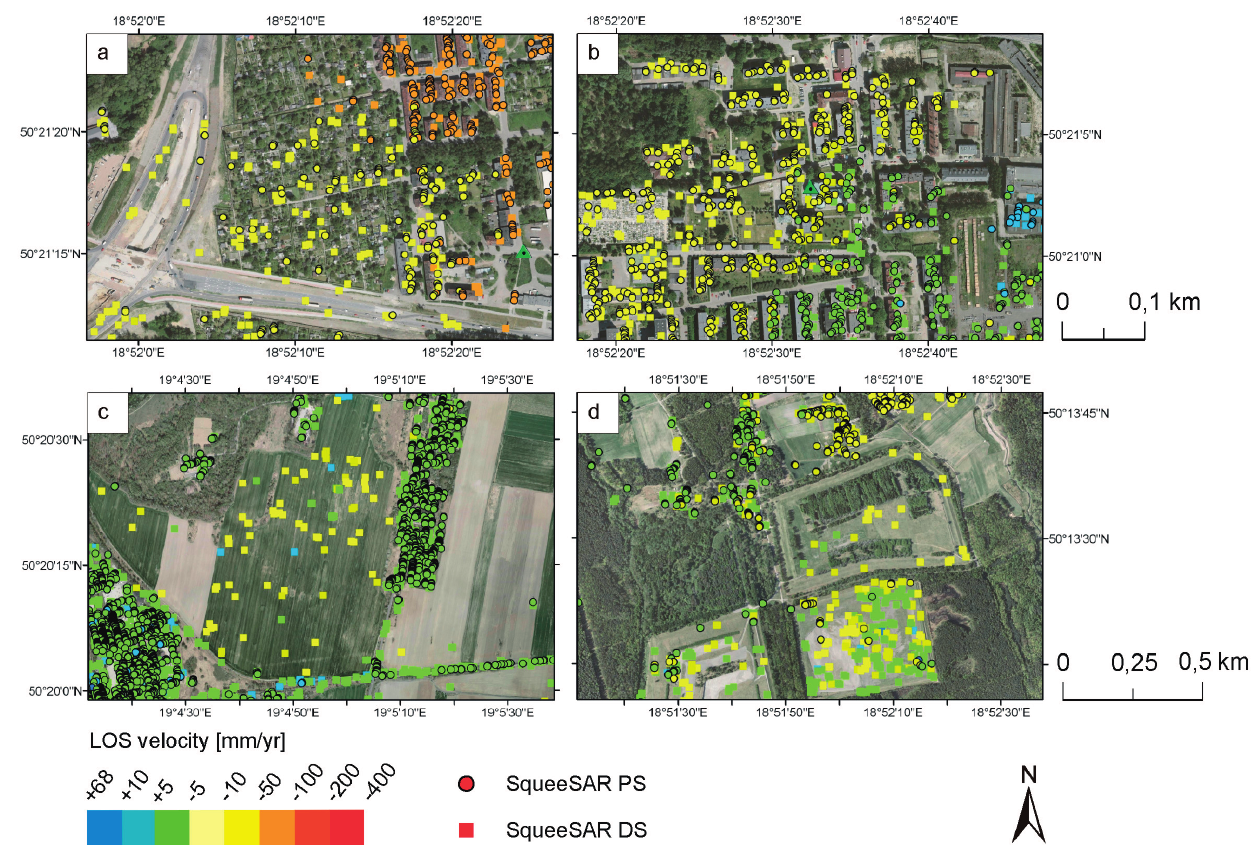
Figure 6. Point scatterers (circles) and distributed scatterers (squares) location over selected areas. Both measurement point (MP) types are presented in the same color scale by their Line of Sight velocity values. ( a ) Crossroad of national road no. 94 and Nowaka- Jeziora ń skiego street in Bytom; ( b ) Popie ł uszki street in Bytom; ( c ) Agricultural area in B ę dzin; ( d ) Agricultural area in Stara Ku ź nia. See location of these areas in Figure 4. The negative skewness in LOS velocity histogram is explained by the dominant subsidence detected in the USCB. The mean standard deviation, 2 mm/year, is consistent with the precision of the PSI techniques. Occasional and scattered higher values of standard deviation up to 11.93 mm per year are observed far away from the reference point (edges of the data frame) as well as in strongly subsiding areas (Figure 4c,d). As in all geodetic networks, the precision of the measurements tends to decrease as the distance from the reference point increases, because of error propagation (uncompensated atmospheric noise). Localized high standard deviation values in areas of motion, have a different explanation: since the average velocity standard deviation is computed from the residual of a linear model fitted to the data, these values indicate that motion is non